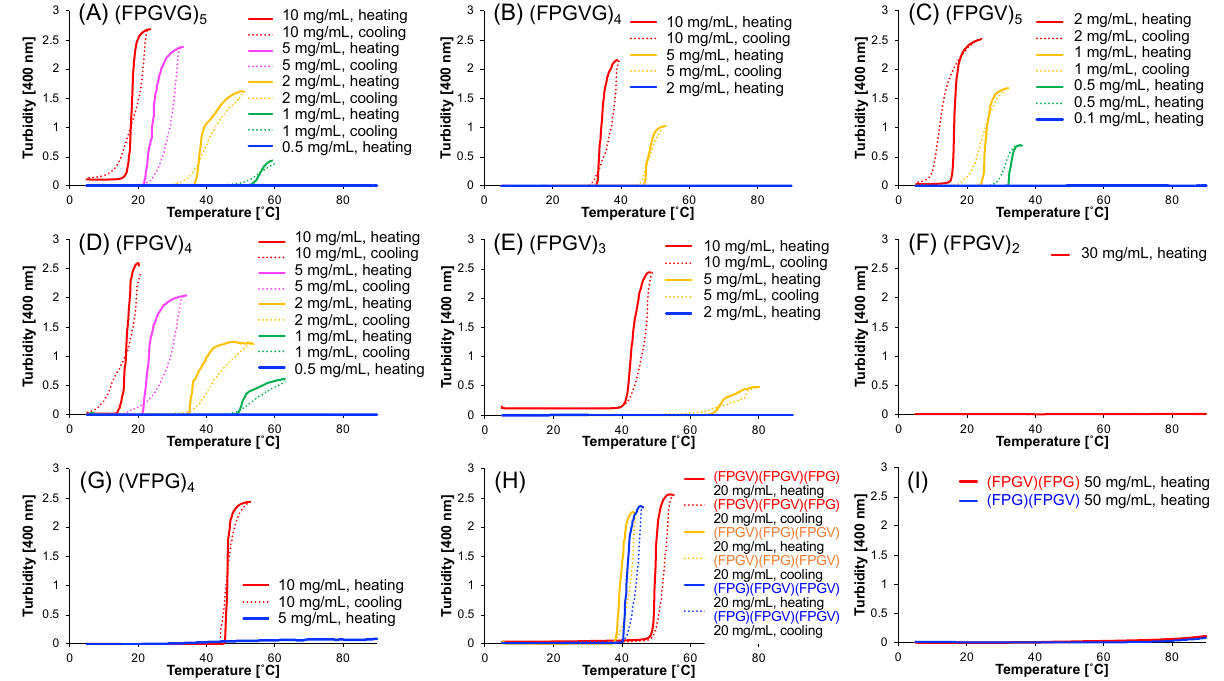
Figure 2. Turbidity profiles of the short elastin-like peptide (ELP) analogues consisting of combinations of FPG and FPGV sequences. Turbidity changes of the synthesized peptides in phosphate buffer (27.4 mM Na 2 HPO 4 , 17.8 mM NaH 2 PO 4 , pH 7.4) associated with heating (solid lines) and cooling (dashed lines). ( A ) (FPGVG) 5 , ( B ) (FPGVG) 4 , ( C ) (FPGV) 5 , ( D ) (FPGV) 4 , ( E ) (FPGV) 3 , ( F ) (FPGV) 2 , ( G ) (VFPG) 4 , ( H ) (FPGV)(FPGV)(FPG) (red lines), (FPGV)(FPG)(FPGV) (orange lines), (FPG)(FPGV)(FPGV) (blue lines), and ( I ) (FPGV)(FPG) (red line), (FPG)(FPGV) (blue